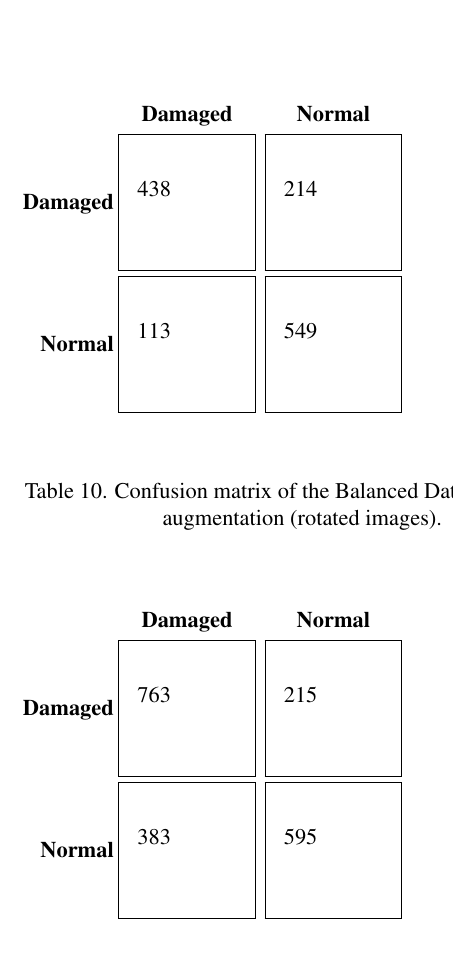
Table 11. Confusion matrix of the Balanced Dataset with data augmentation (flipped and rotated